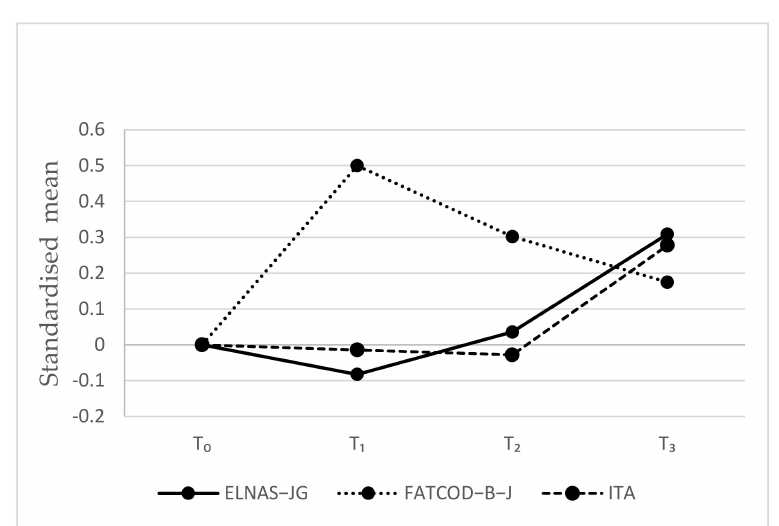
Figure A1. Changes in the standardized mean scores on the ELNAS-JG, FATCOD-B-J, and ITA for nurses. ( n = 14). Note: ELNAS-JG: End-of-Life Care Nursing Attitude Scale for Japanese Geriatric Nurses; FATCOD-B-J: Japanese version of the Frommelt Attitudes Toward Care of the Dying Scale; ITA (Abbreviated): Assessment Scale of Health Care Professionals’ Recognition of a Successful Interdisciplinary Team Approach in Health Care Facilities for the Elderly. Scores at the three timepoints (T 1 , T 2 , T 3 ) were standardized using the mean and standard deviation at baseline (T 0 ). Z = (x − µ 0 )/ σ 0 ; µ 0 and σ 0 indicate the mean and standard deviation, respectively, at T 0 .